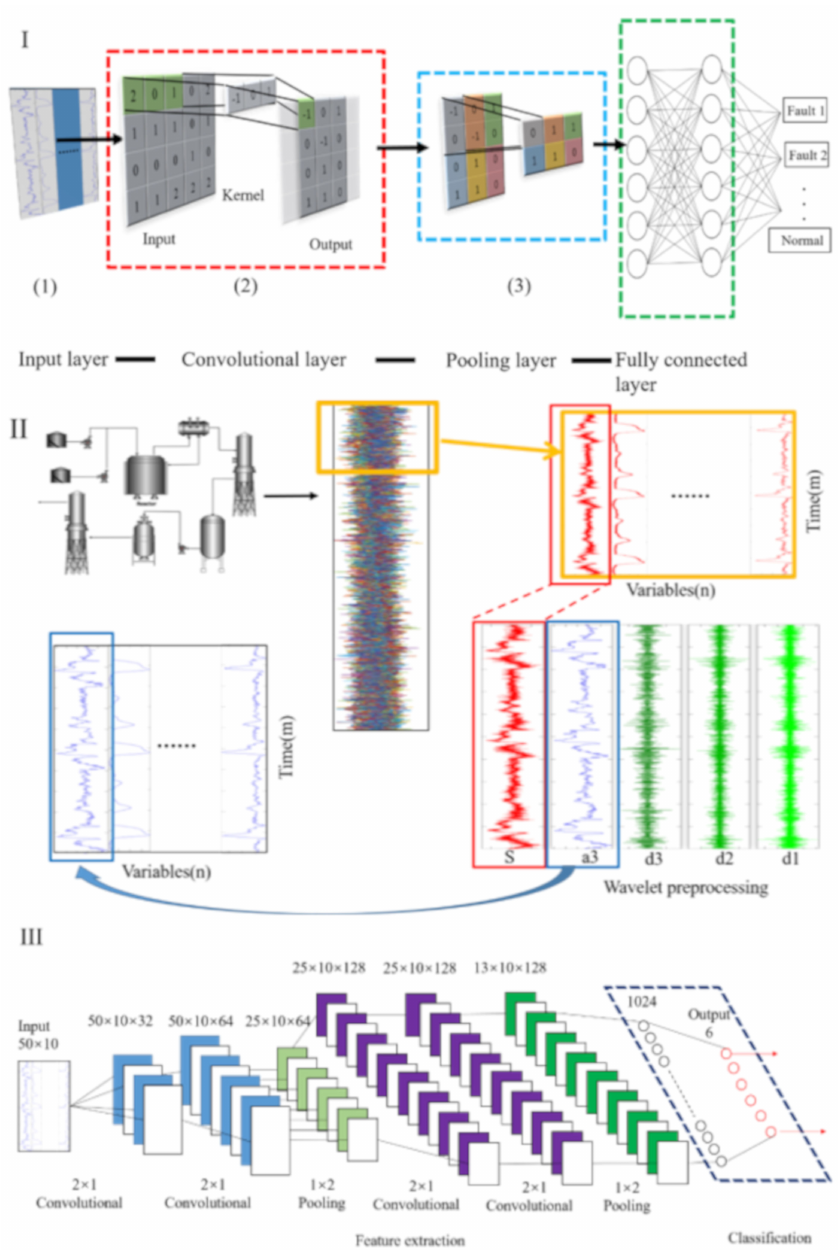
Figure 4. Implementation details of WCNN multi-model monitoring method. ( I ) details of the preliminary fault detecting and diagnosing model; ( II ) process of data acquisition and wavelet preprocessing; ( III ) details of the secondary fault diagnosing